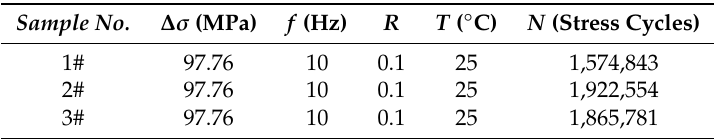
Figure 15. ( a ) Positions of initial cracks in test pieces; ( b ) 1# test piece after the fatigue test; ( c ) 2# test piece after the fatigue test; ( d ) 3# test piece after the fatigue test. Table 3. Results of the fatigue experiments.